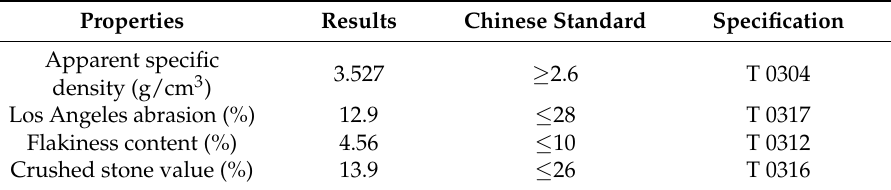
Table 3. Properties of steel slag.